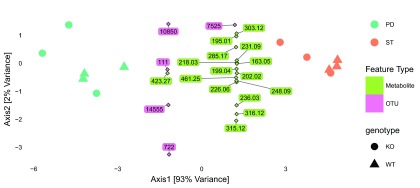
A PCA triplot produced from the CCA selected features in from muliple data types (metabolites and OTUs).Note that we have departed from our convention of fixing the aspect ratio here as the second axis represents very little of the variability and the plot would actually become unreadable.